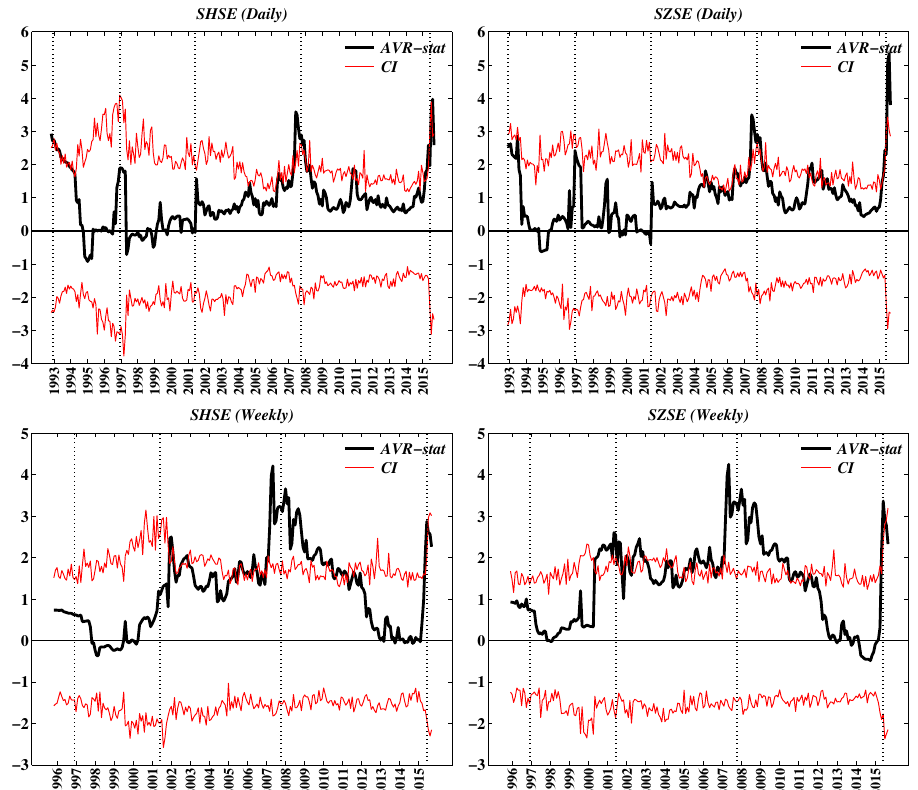
Fig. 1. Time-varying statistics of the AVR test of the daily and weekly data in the SHSE and the SZSE from December 1990 to September 2015. CI is the con¯dence interval associated with the statistic at the signi¯cance level of 5 % . The time t represents the time window ½ t (cid:1) 1 ; t (cid:2) for daily data, and ½ t (cid:1) 4 ; t (cid:2) for weekly